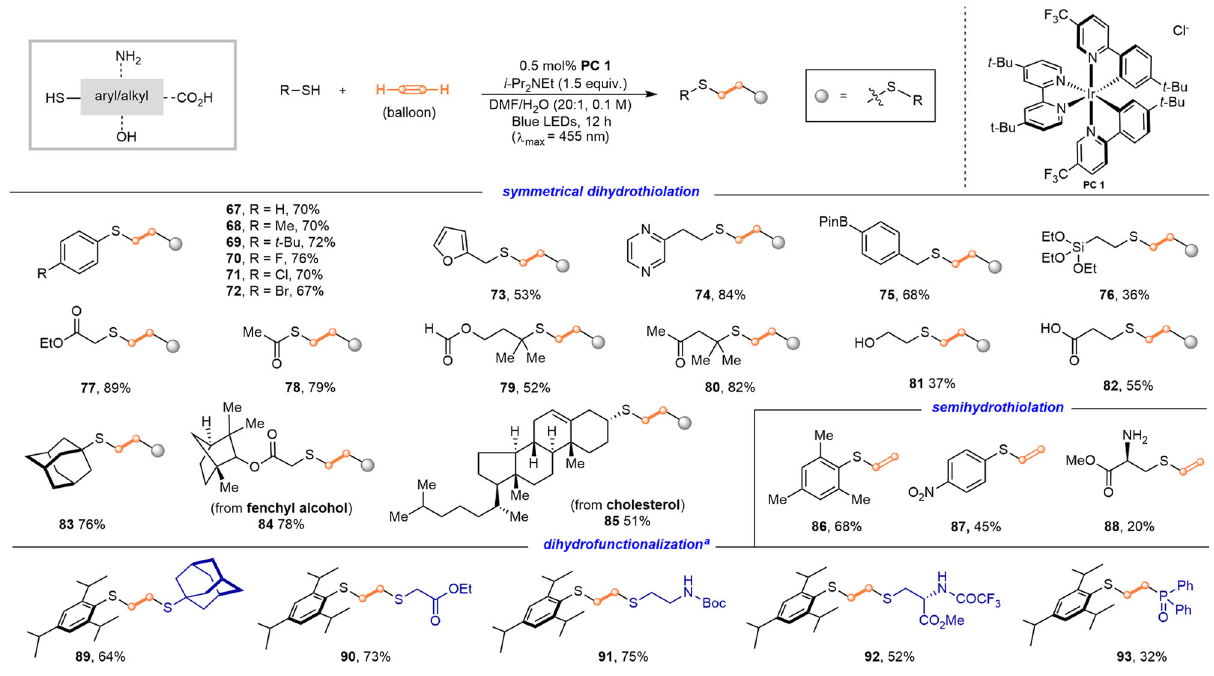
Fig. 4 | Substrate scope for synthesis of linear C2-linked 1,2-bisthioether. Reactionconditions:Thiols(0.5mmol), PC1 (0.5mol%)andaballoonwas fi lledwith acetylene gas until its size was roughly 20cm in diameter. 4-Chlorobenzyl-